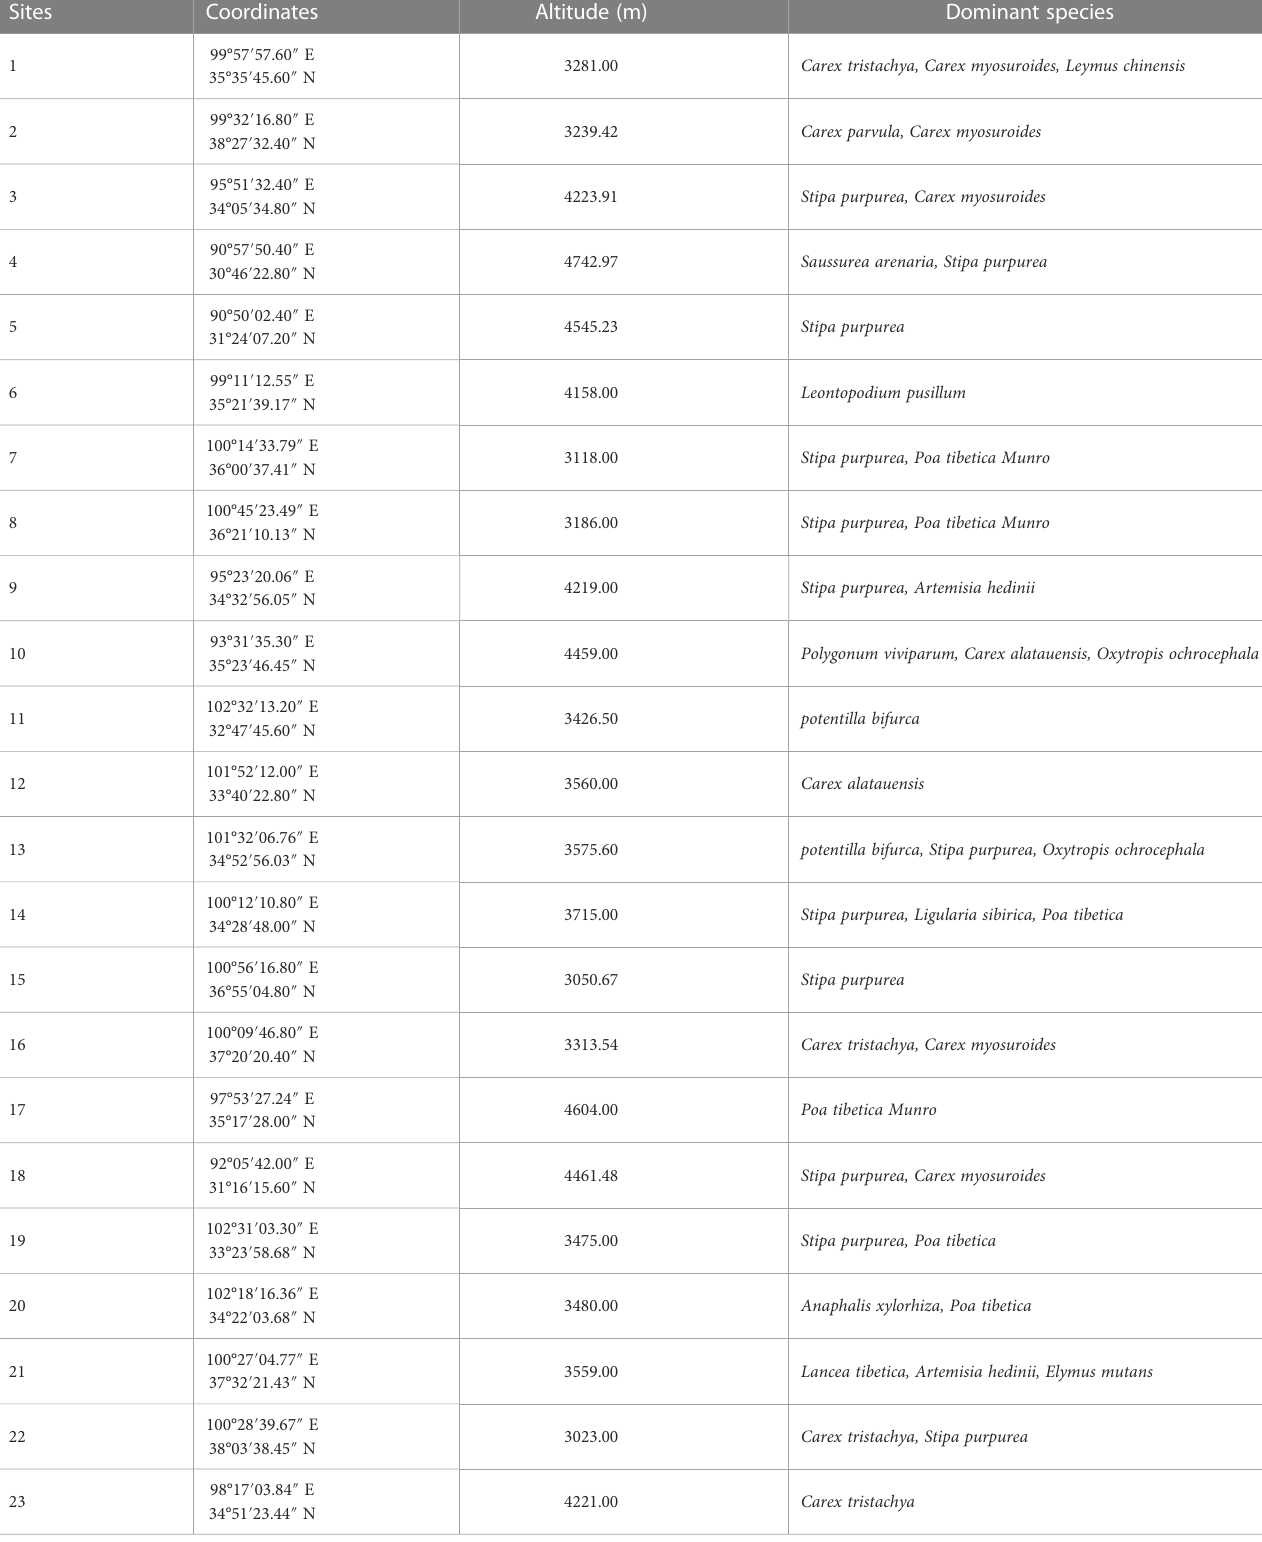
TABLE 1 Spatial information of sample sites and dominant species of